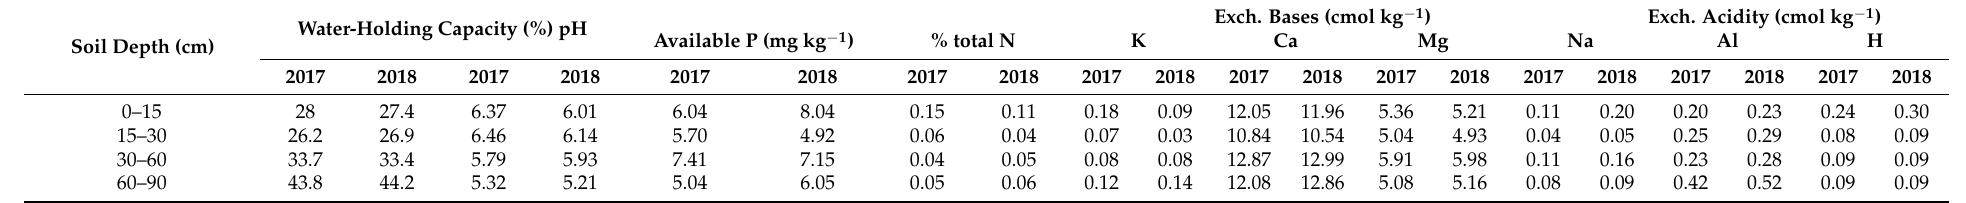
Table 2. Average chemical characteristics of top and subsoil (0–90 cm depth) at Fumesua.